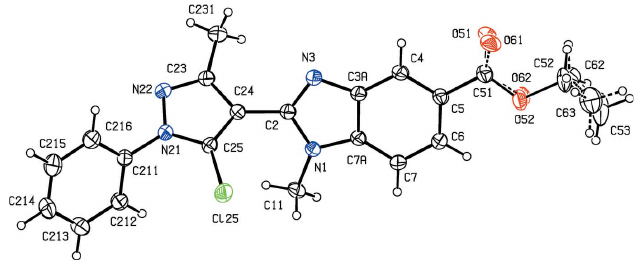
Figure 3 The molecular structure of compound (III) showing the atom-labelling scheme and the disorder. The major disorder form is drawn using full lines and the minor disorder component is drawn using broken lines. Displacement ellipsoids are drawn at the 30% probability level.